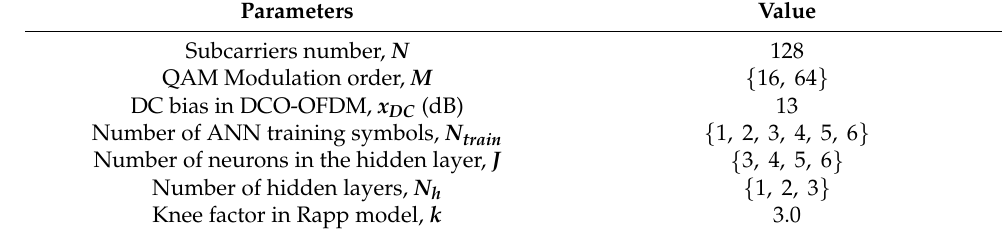
Table 2. Summary of simulation parameters.